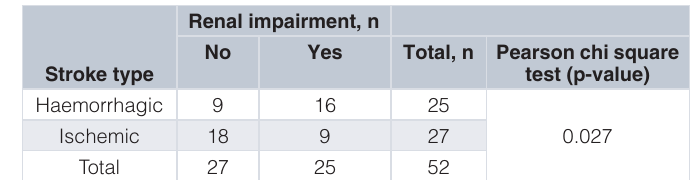
Table 2. Crosstablulation of haemorrhagic and ischemic stroke patients with and without renal impairment. Renal impairment, n No Yes Total, n Pearson chi square Stroke type